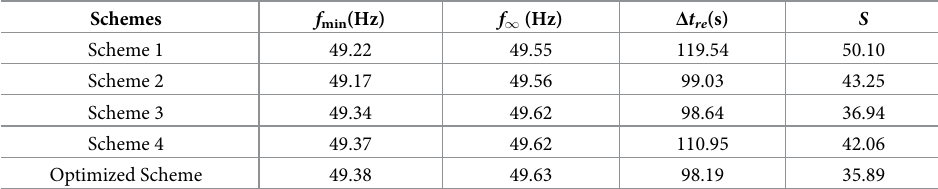
Table 15. Simulation analysis results for different schemes (Case